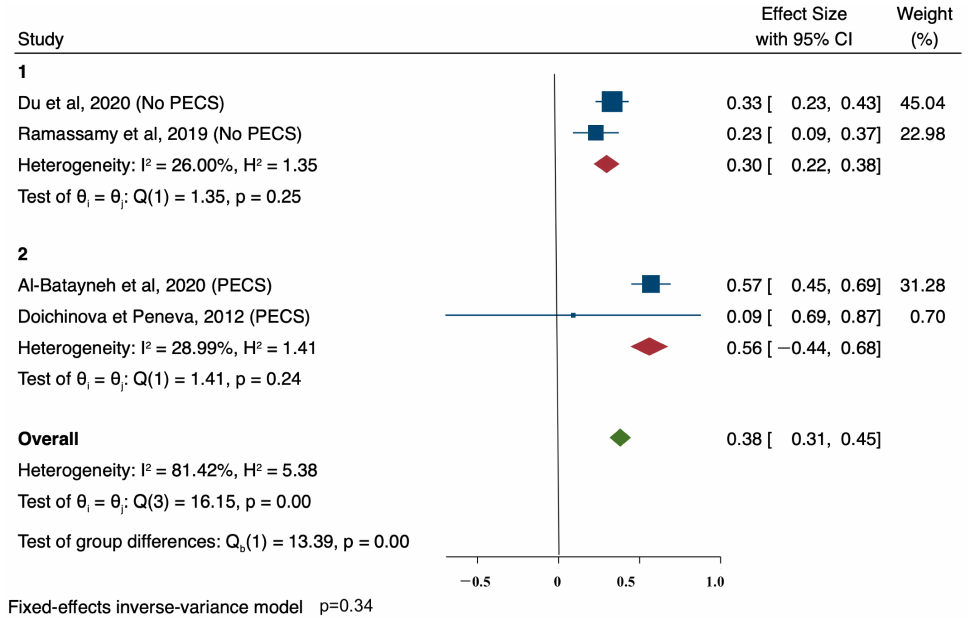
Figure 3. Meta—analysis of Plaque Index outcomes and subgroup analysis by the type of tool (PECS vs. other type of visual